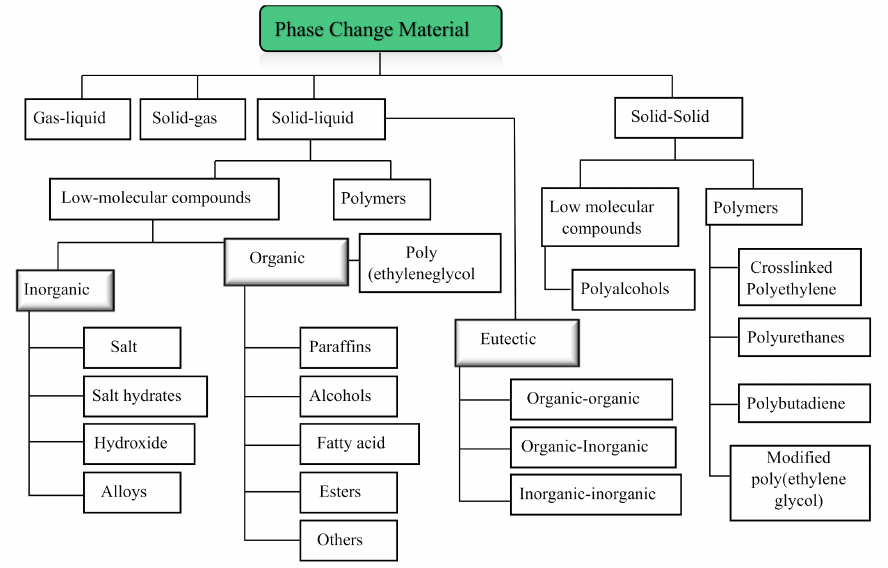
Figure 7. Classification of phase change materials